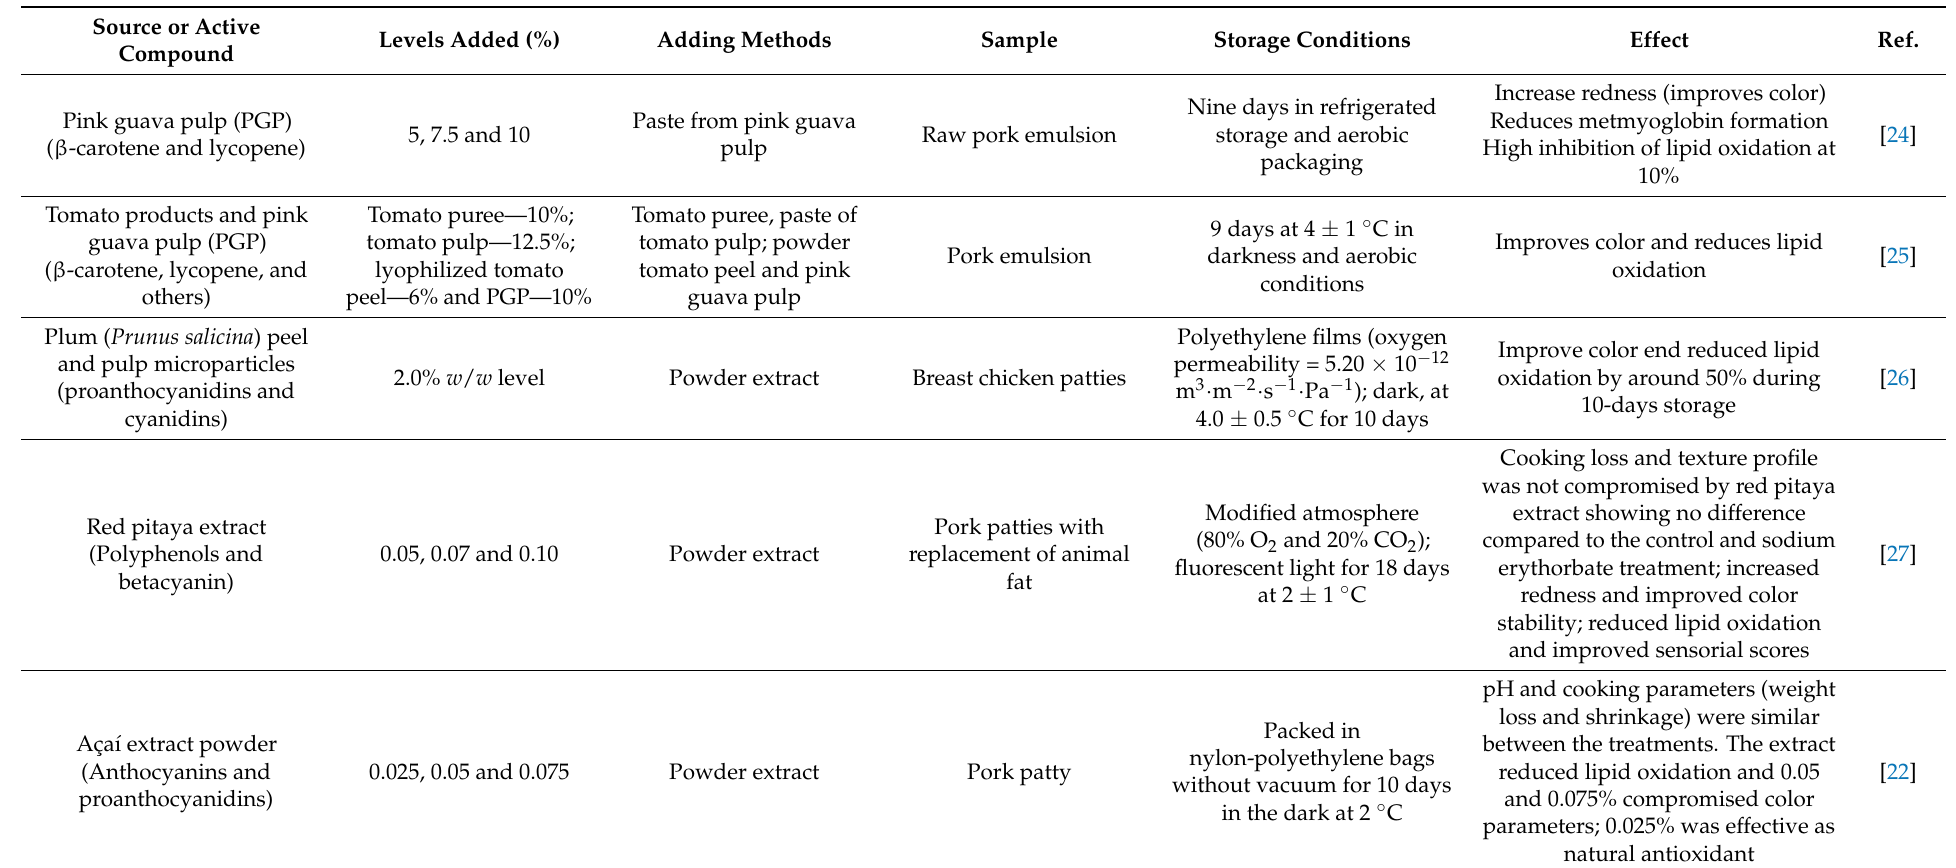
Table 1. Fruit (pulp, pigment, peel, and seeds) as a source of antioxidants applied in meat